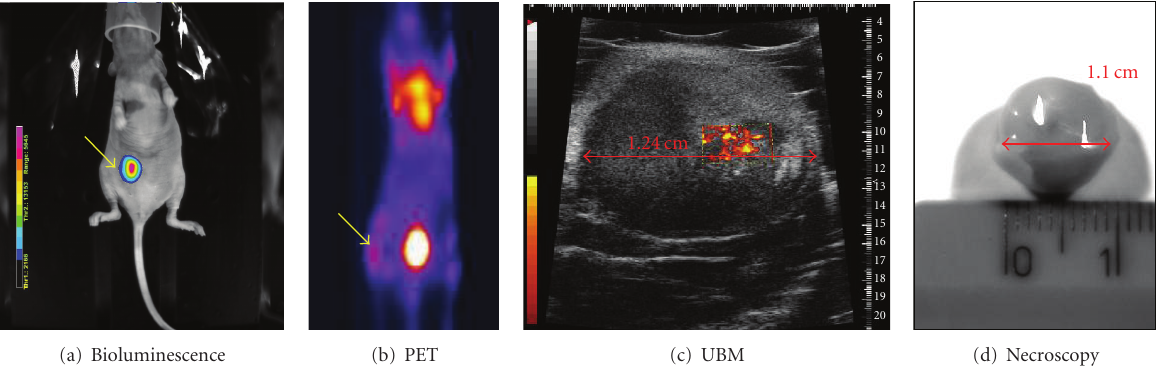
Figure 9: Multimodality imaging of the lesion: human mammary tumor cells were implanted in the mammary fat pad of an athymic nude mice, 6 weeks old. There is a good correspondence between the morphology and the size of the tumor detected by UBM and necroscopic findings. (a) Bioluminescence of the tumor. (b) 18 F-flourothymidine total body PET, tumor uptake is evident (arrow). (c) UBM with measurements of neoplasia. (d) Post mortem dimension of the explanted